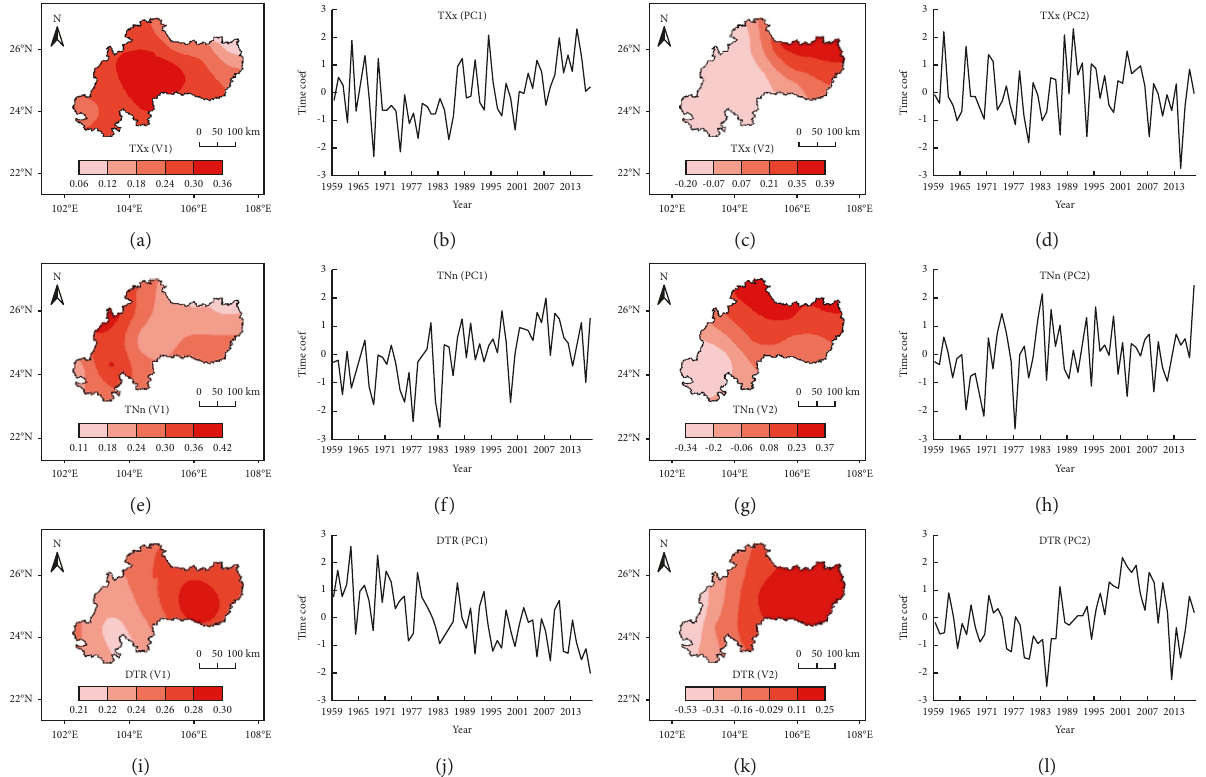
Figure 4: The first and second eigenvectors and their time coefficients of extreme temperature intensity